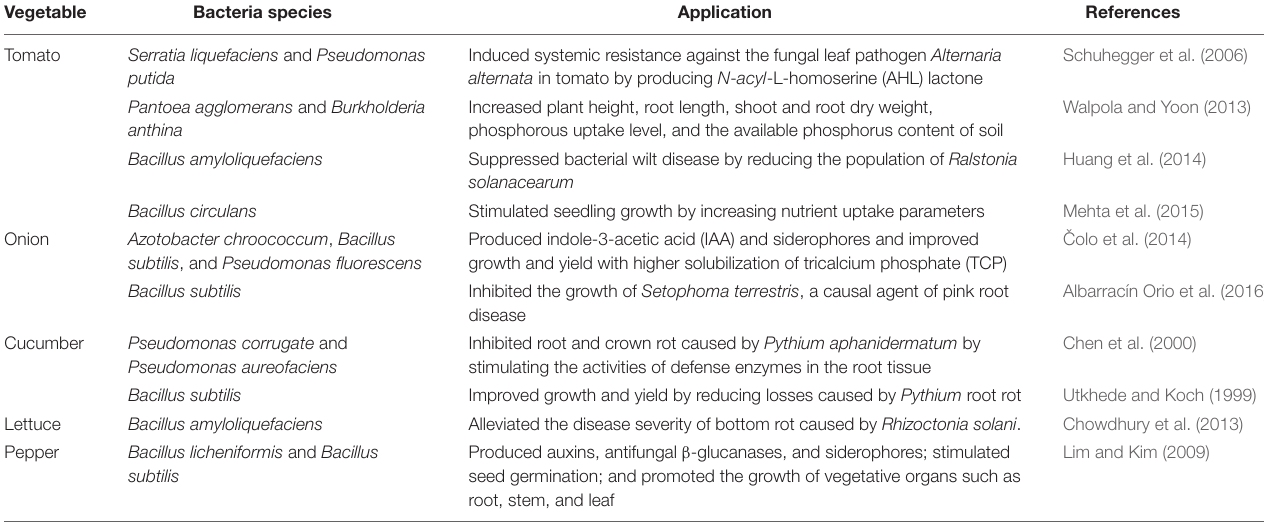
TABLE 2 | Typical cases of bacterial effects on vegetable production.